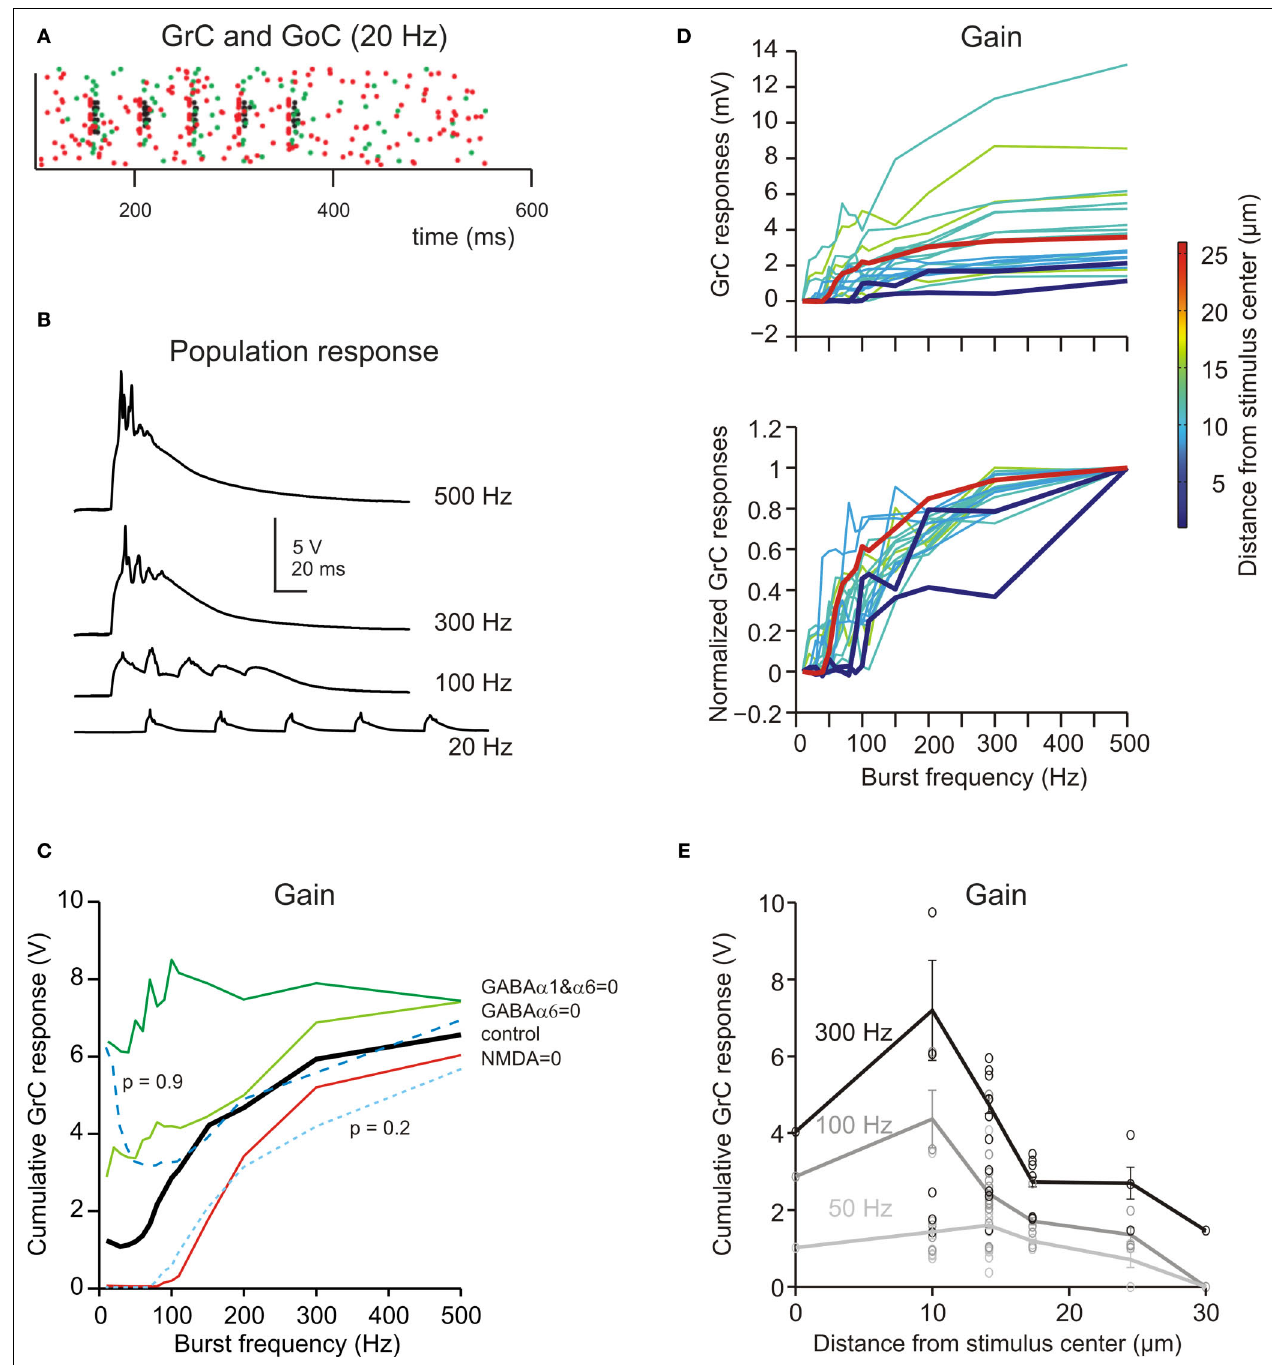
all frequencies, while raising release probability ( p = 0.9) enhanced the gain curve specifi cally at low frequency. (D) The gain curve changed from the center to surround of the excited area. In the center the gain curve arose at lower frequencies and attained higher gain than in the surround. (i) shows absolute gain curves, (ii) shows normalized gain curves. Each gain trace is from a different GrC. (E) Gain as a function of distance from the center of the active areas. The points are measures in responding spots located along different radii (mean ± sd indicate the values along the whole circumference at the given distance; see Materials and Methods for details). The difference between center and surround in terms of gain was more pronounced at high than low input